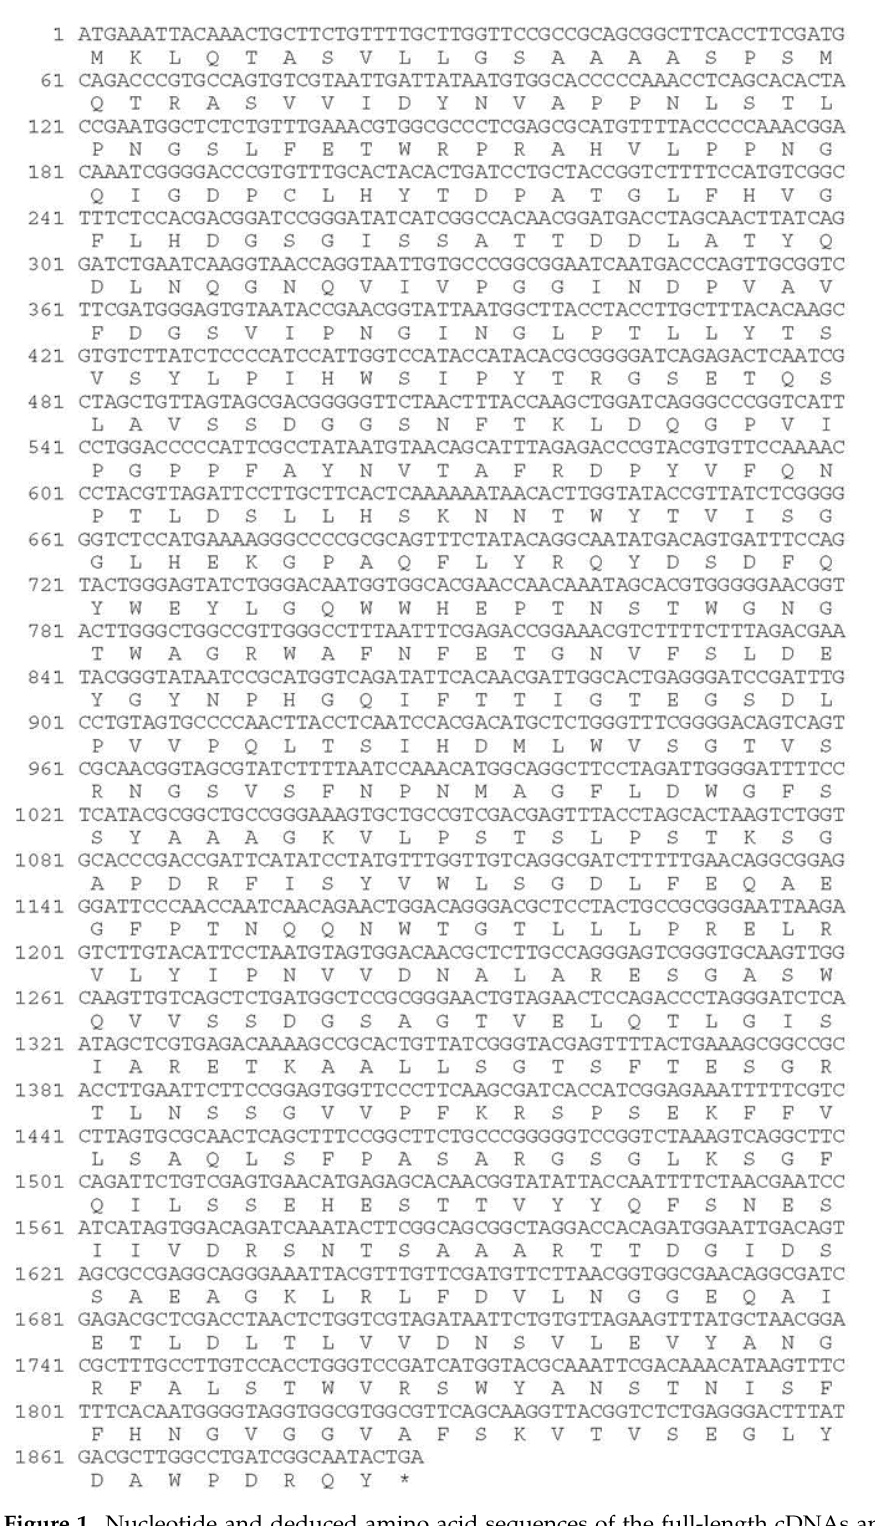
Figure 1. Nucleotide and deduced amino acid sequences of the full-length cDNAs and flanking regions of AlFFase3.